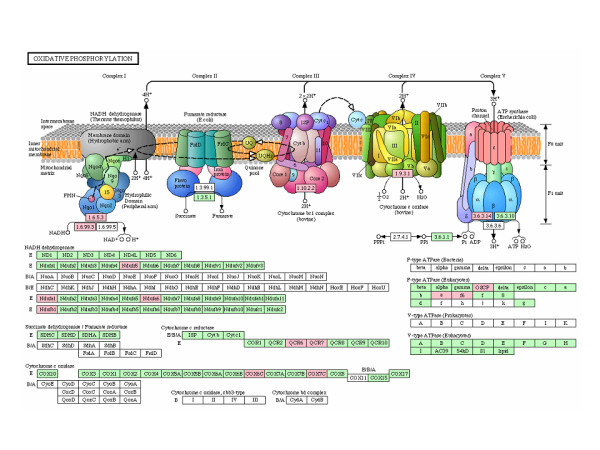
KEGG pathway diagram including the 11 oxidative phosphorylation system (OXPHOS) genes selected by microarray analysis. In the upper part are shown the five respiratory chain complexes with the corresponding E.C. numbers. In the bottom part, as rectangles, are indicated the subunits of each respiratory chain complex. The subunits encoded by genes selected by microarray analysis are shown by colored (pink shaded) rectangles.